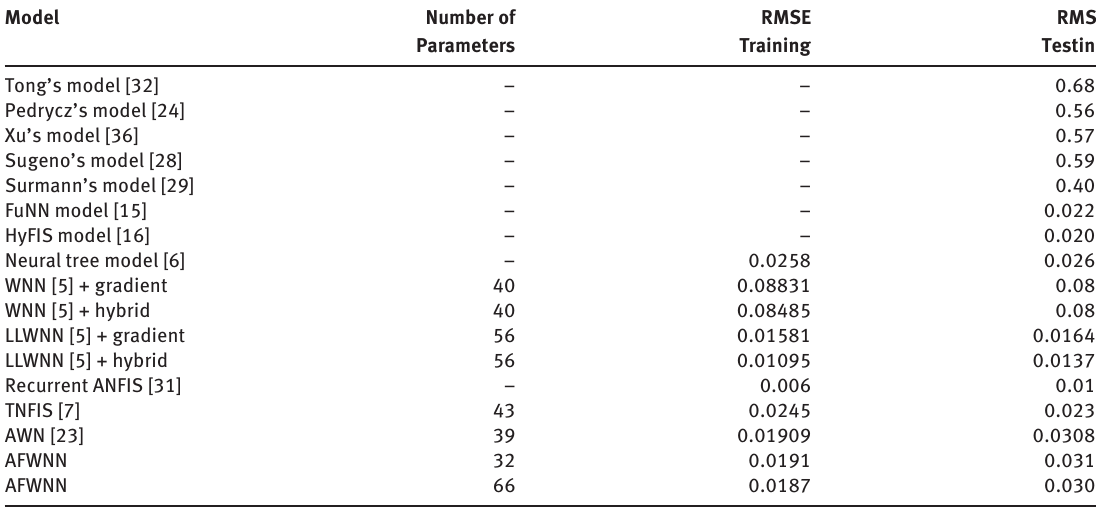
Table 1. Comparison of Different Models for Box Jenkins Time